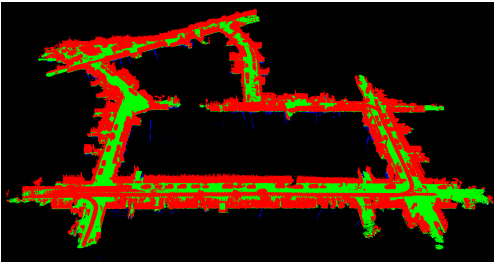
Figure 4. Based on the terrain modeling result, the map point cloud is divided into the noise part below the terrain M n (shown in blue), the terrain part M g (shown in green), and the obstacle point cloud above the terrain M o (shown in